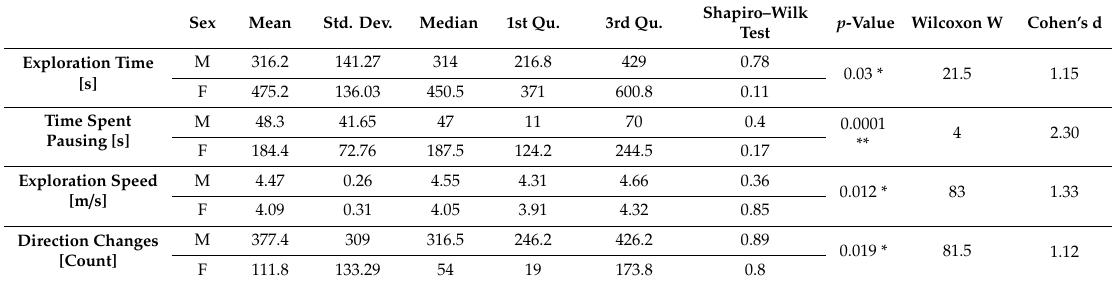
Table 1. Analysis of measured variables according to sex.